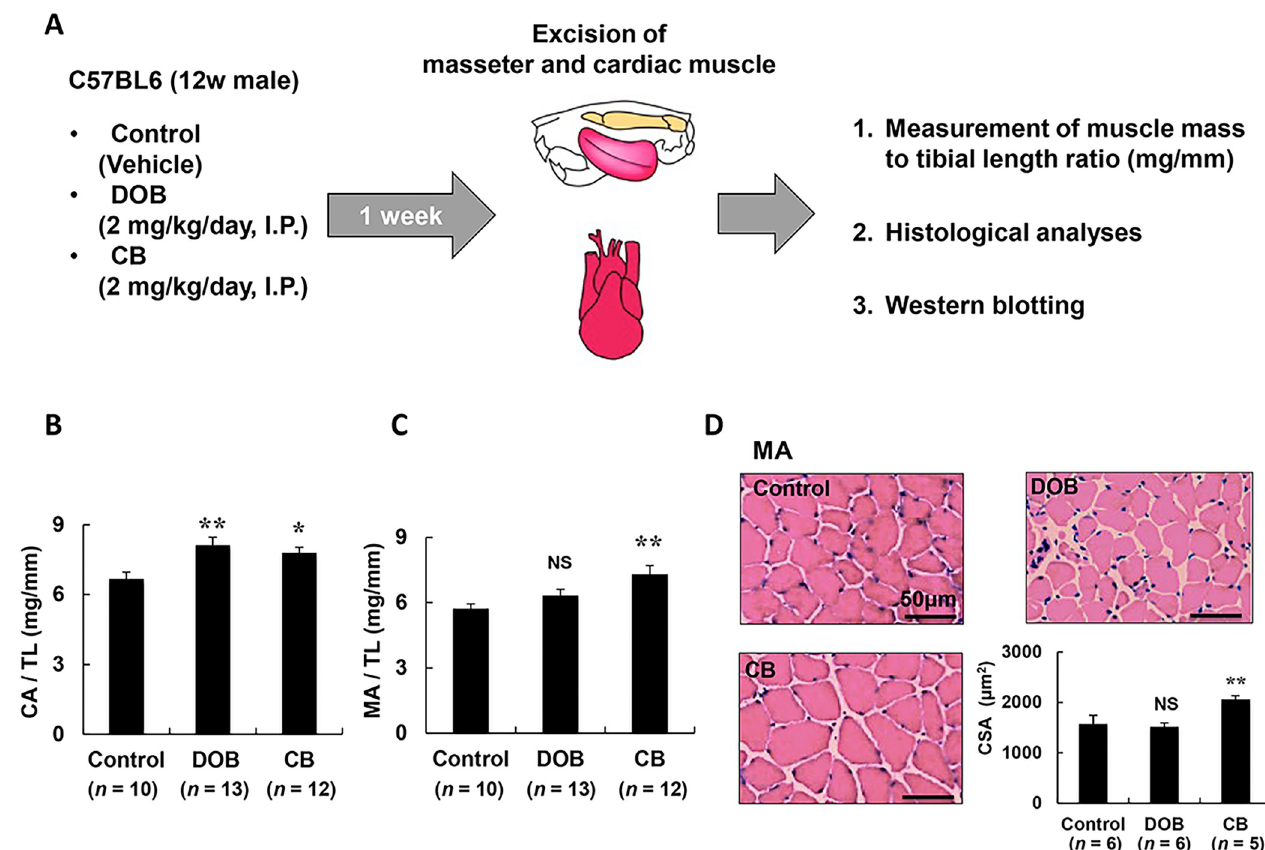
Fig 1. Experimental procedure, daily consumption of food and water, and body weight. (A) Dobutamine (DOB) and clenbuterol (CB) was administered once daily for 1 week via intraperitoneal injection (I.P.) at a dose of 2 mg/kg, dissolved in saline. Age-matched control mice (Control) received an identical volume of saline only. (B) In cardiac muscle (CA), the muscle mass per tibial length ratio was significantly increased in the DOB group ( �� P < 0.01 vs. Control), as well as the CB group ( � P < 0.05 vs. Control). (C) In masseter muscle (MA), the muscle mass per tibial length ratio was significantly increased in the CB group ( �� P < 0.01 vs. Control), but not in the DOB group (D) Typical cross-sections of HE staining of masseter muscle (MA) in the three groups (Control ( upper left ), DOB ( upper right ) and CB ( lower left )). CSA was significantly increased in the CB group ( �� P < 0.01 vs. Control), but not in the DOB group ( lower right ). Scale bars: 50 μ